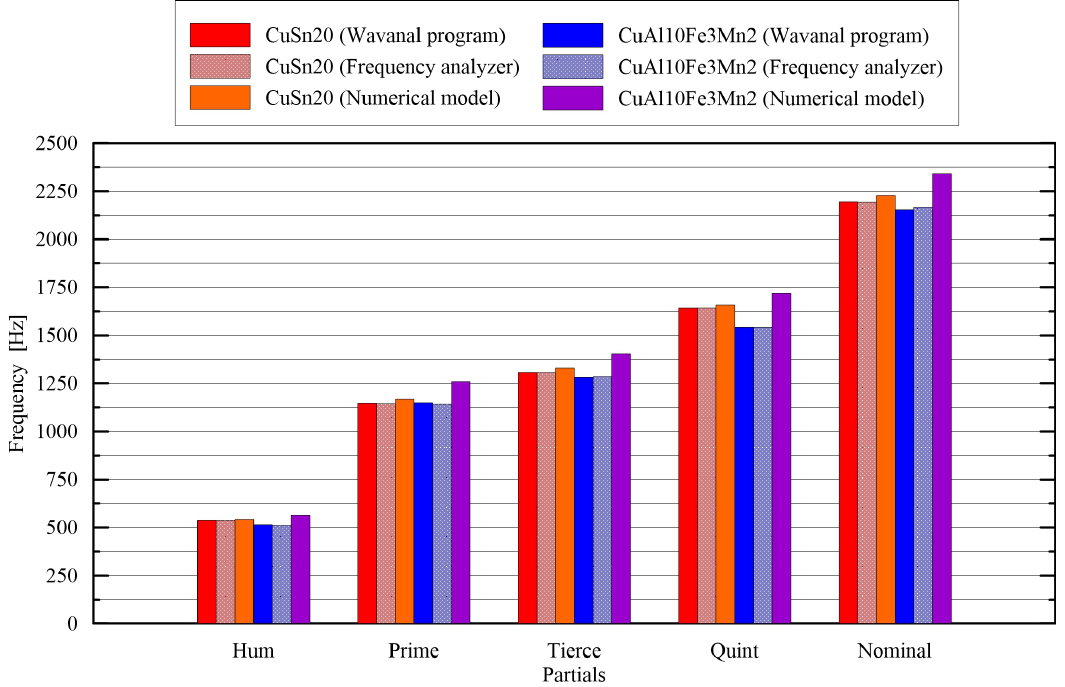
Figure 16. Comparison of the experimental and numerical